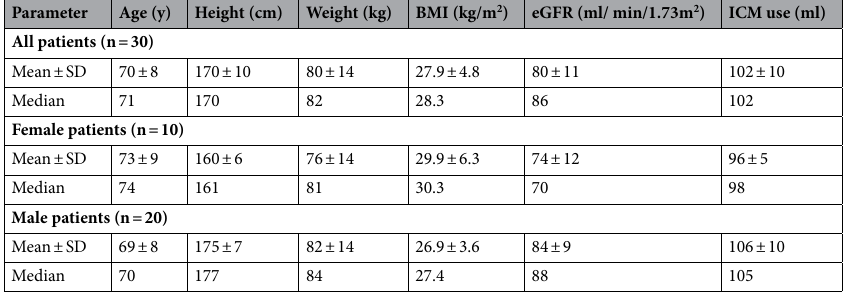
Table 1. Patient demographics. The ICM column shows the total procedural ICM use. BMI body mass index, ICM iodinated contrast media, SD standard